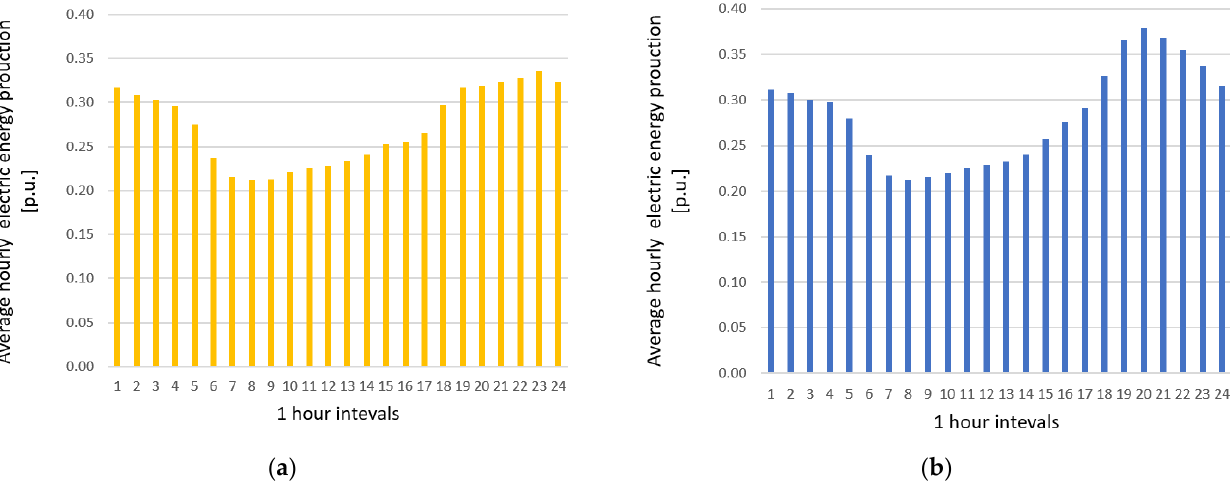
Figure 4. ( a ) Daily variability of hourly energy production of Wind Farm A; ( b ) Daily variability of hourly energy production of Wind Farm B.